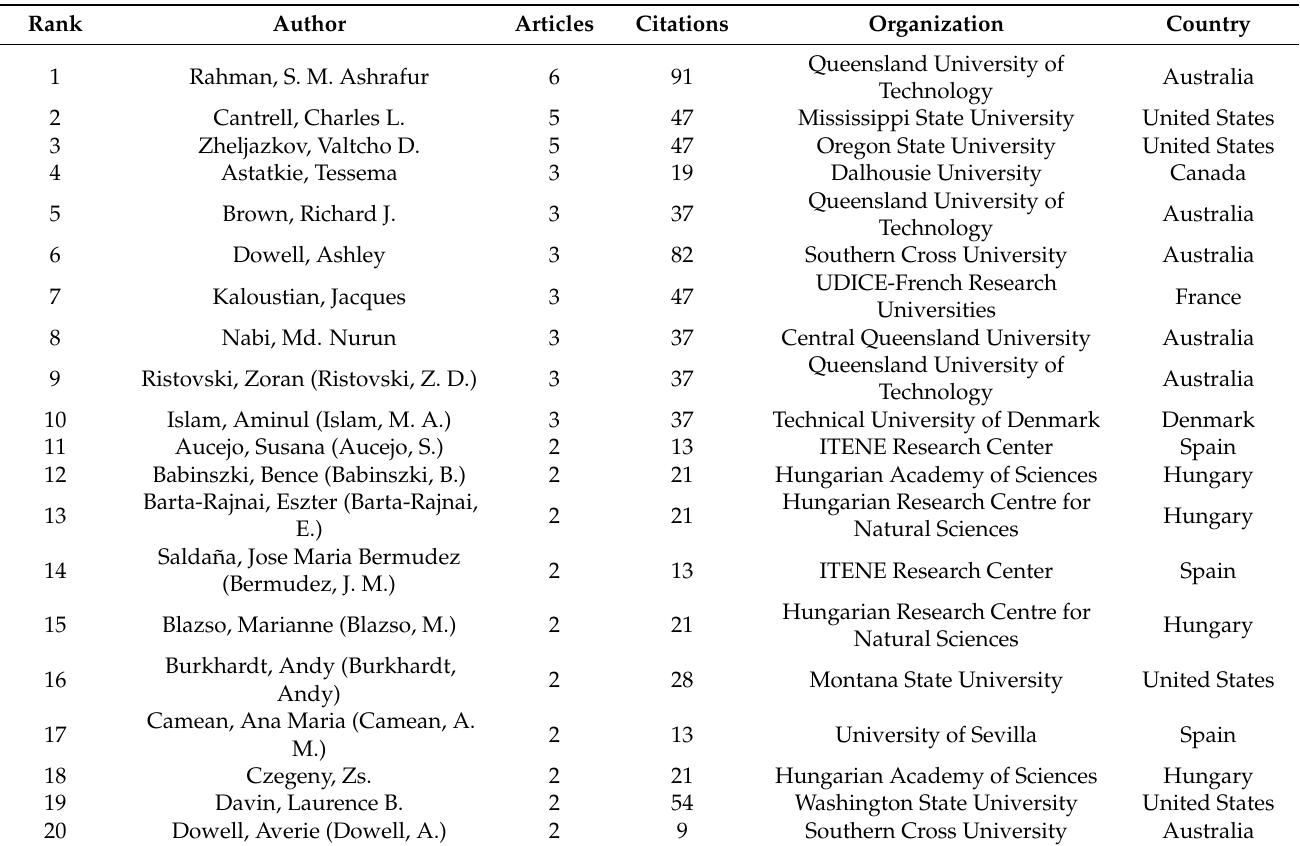
Figure 2. Web of Science network visualization map of authors of studies on biodiesel production from essential oil. Table 4. Top 20 most prolific authors who published articles in the field of biodiesel production from essential oil on Web of